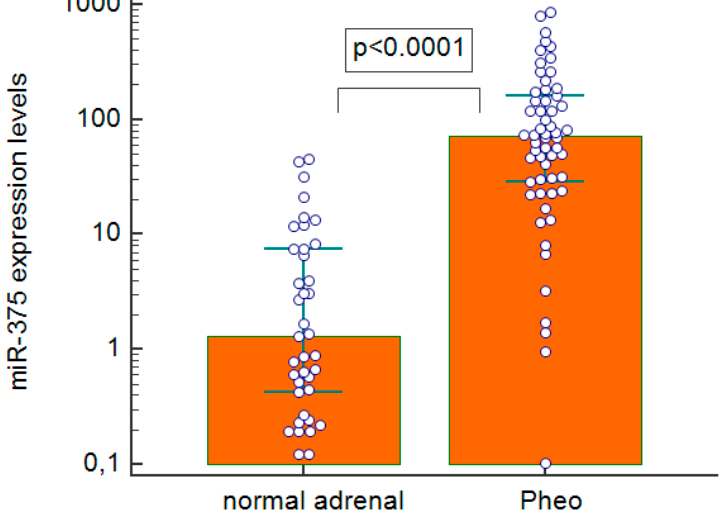
Figure 4. Real-time quantitative PCR expression levels of miR-375 in pheochromocytoma specimens and normal adrenal tissues; Pheo: pheochromocytoma.